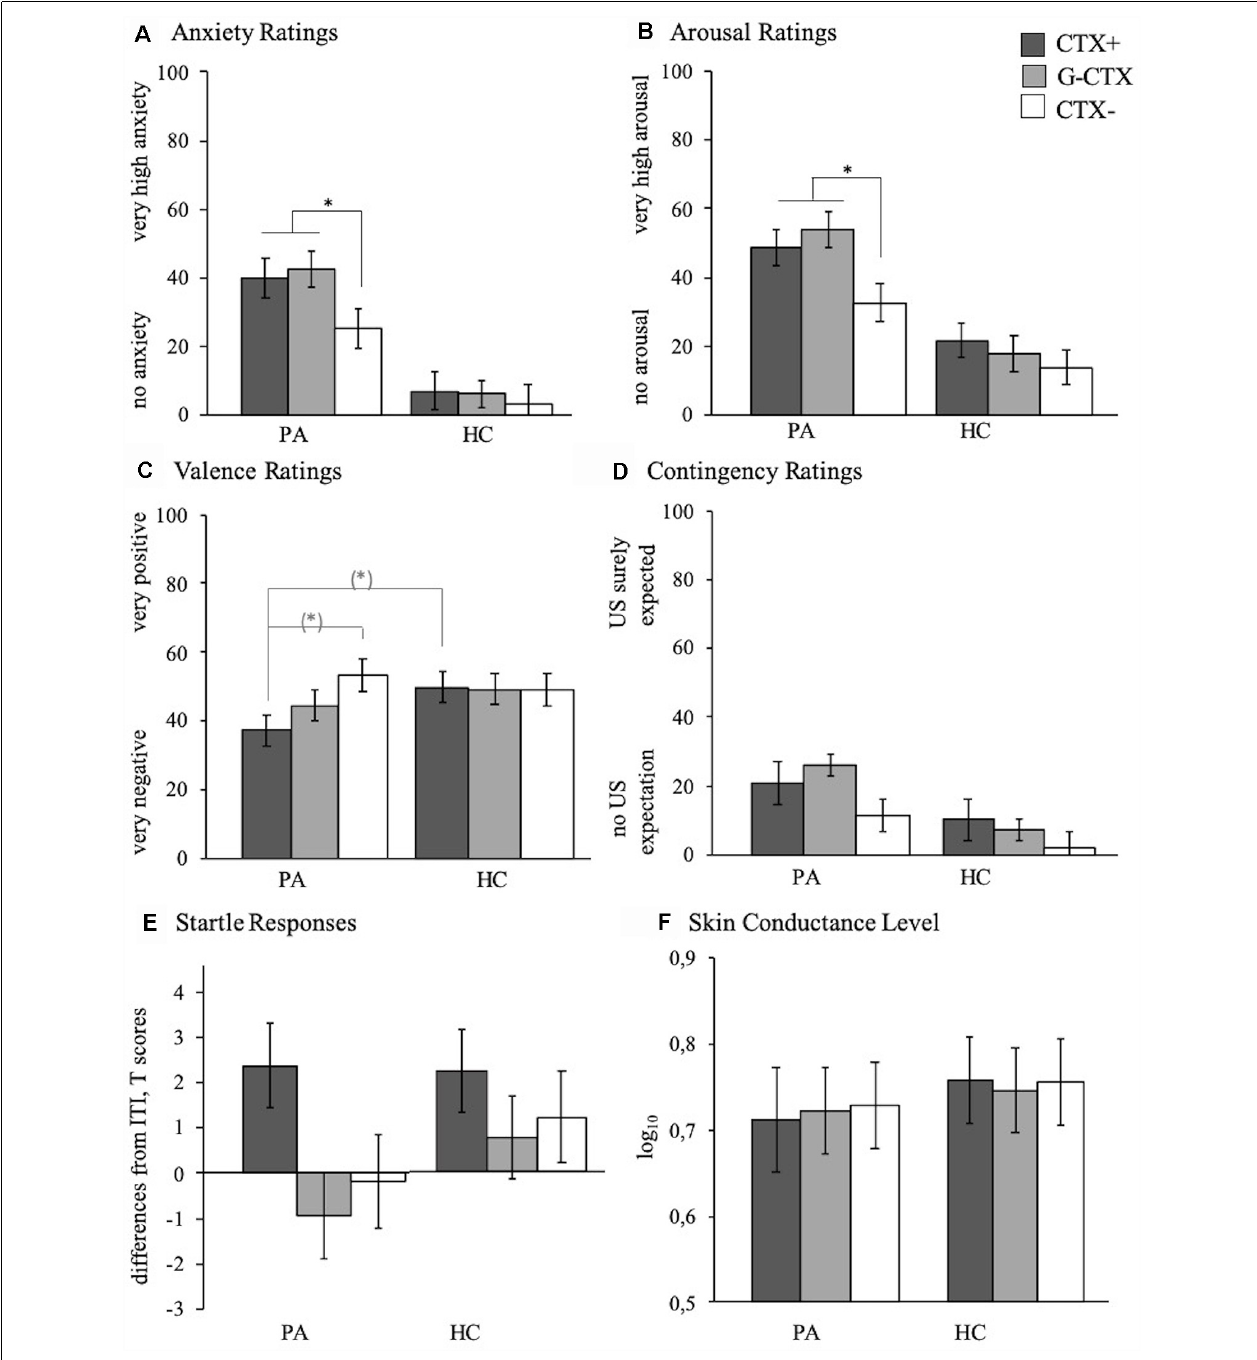
FIGURE 3 | Anxiety (A) , arousal (B) , valence (C) , and contingency (D) ratings as well as startle amplitude (E) and SCL (F) of participants with PA (left bars) and HC (right bars) to the CTX+ (gray) and the CTX − (white) during the generalization phase (GEN). Depicted are mean responses (means and standard errors). ∗ p < 0.050, ( ∗ )indicates only marginally significant